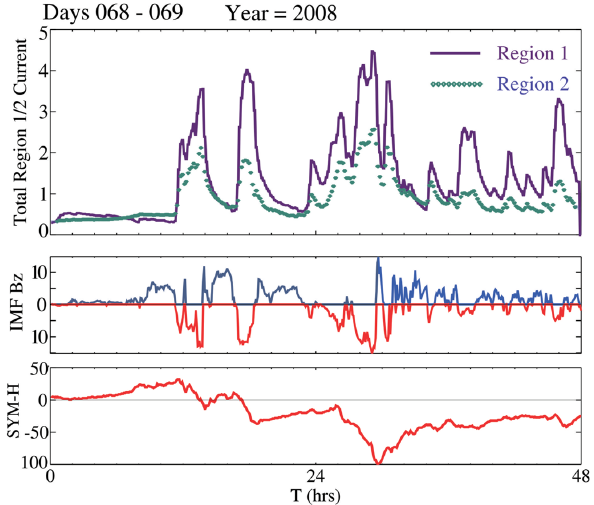
Fig. 19. The top panel shows the variation of the total R1 (dark purple) and R2 (green) FACs (in MA) during the moderate storm of 8–10 March, 2008, as reproduced by the T13 model. The centre and bottom panels show the concurrent variations of IMF B z and the SYM-H index, respectively.